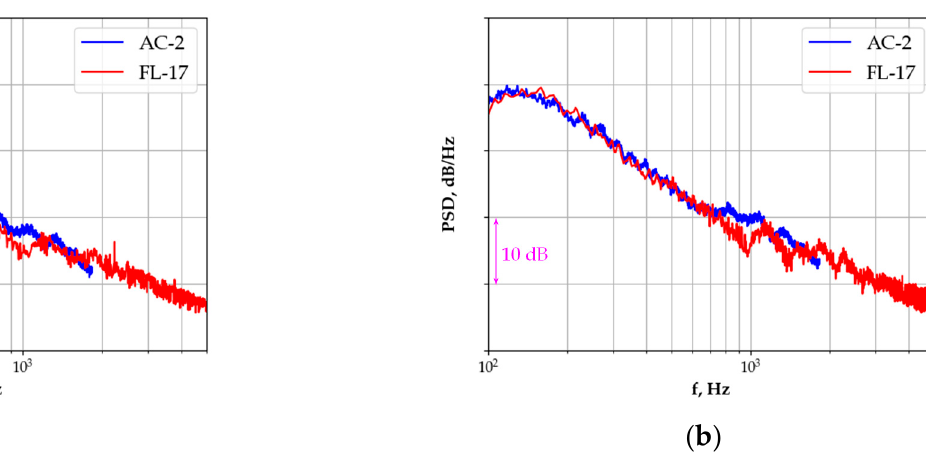
Figure 15. Comparison of the normalized spectra of the four-wheel landing gear model with the high main leg. Microphone is at ( θ , φ ) = (90°, 20°). Flow speed is ( a ) 34 m s − 1 , ( b ) 55 m s − 1 .